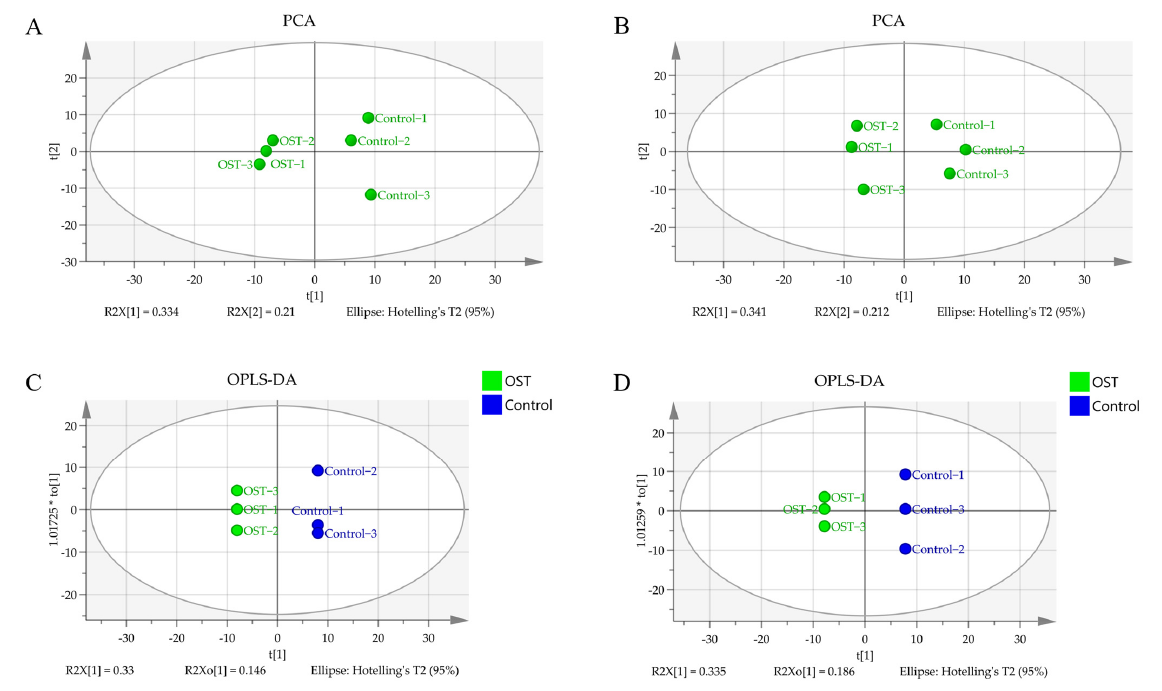
Figure 7. Principal component analysis scoring plots for endogenous metabolites of 4T1 cells in electrospray ionization-positive (ESI + ) mode ( A ) and ESI − mode ( B ), orthogonal projections to latent structures discriminant analysis (OPLS-DA) scoring plots for ESI + mode ( C ) and ESI − mode ( D ).